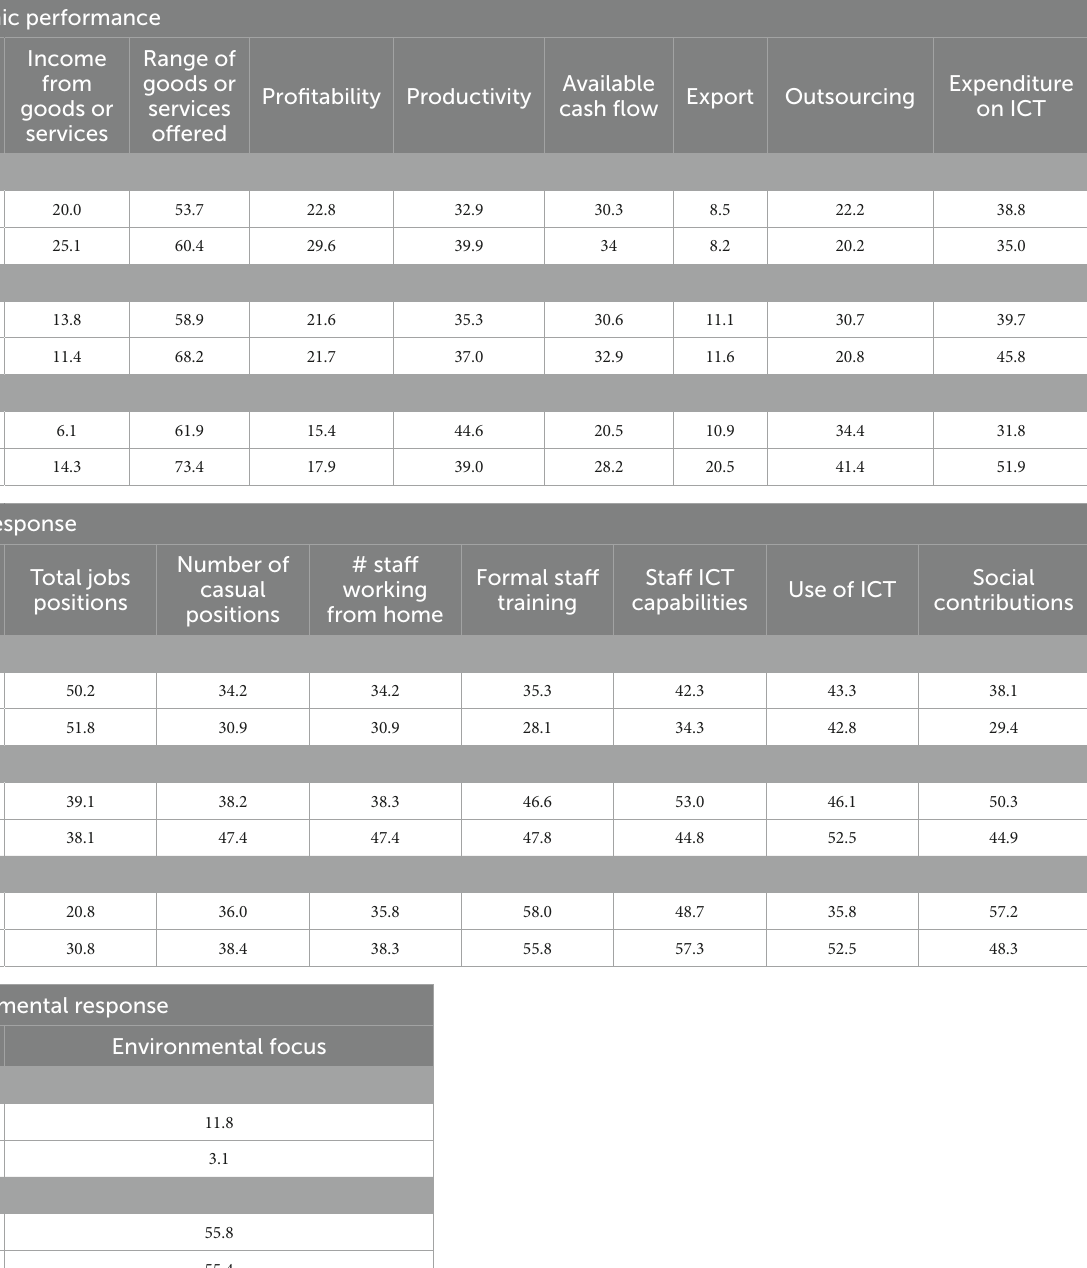
TABLE 3 The percentage of businesses with static performance. Panel A. Economic performance